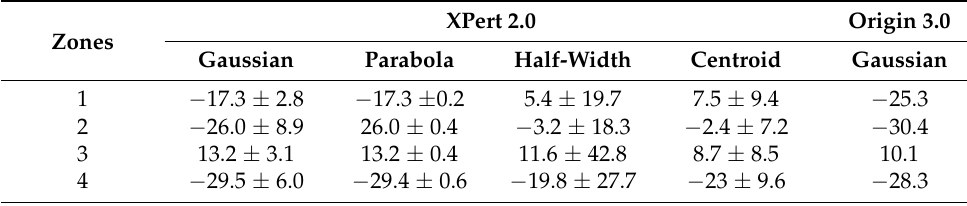
Table 2. Residual stresses of alumina alloy 1060